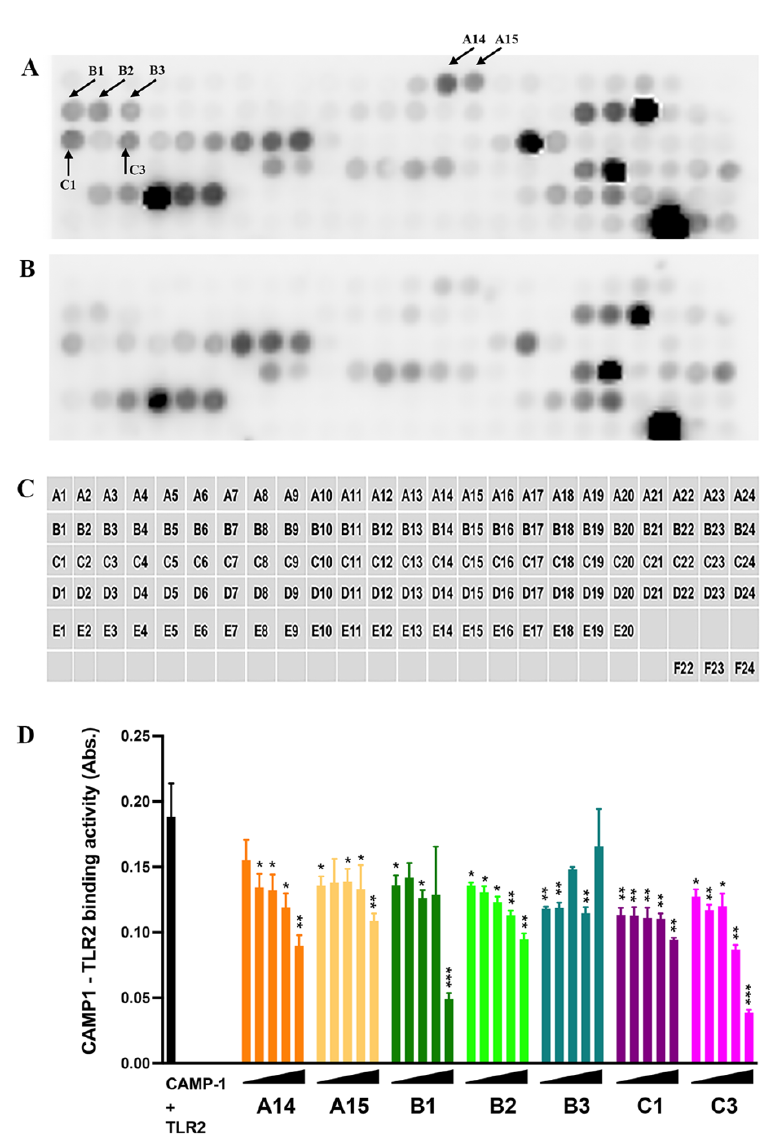
Figure 4. Subpeptides from CAMP1 recognized by TLR-2. ( A , B , C ) The peptides derived from CAMP1 proteins: group F (positions A1-C21), group A (positions C22-E9), group C (positions E10-E13), group D (positions E14-E17), group E (positions E18-E20); a biotinylated peptide used as a positive control (position F22) and a peptide used as a negative control (position F24), were immobilized on glass plates. ( A ) The plates were incubated with TLR-2 (10 µ g/mL)/anti-TLR-2 antibody (0.1 µ g/mL)/HRP (0.5 µ g/mL) and ( B ) with anti-TLR-2 antibody (0.1 µ g/mL)/HRP (0.5 µ g/mL). The arrows indicate the positions of peptides specifically recognized by TLR-2. ( D ) Immobilized rCAMP1 (20 µ g/mL) proteins were probed with biotinylated TRL-2 (0.5 µ g/mL) (dark bar) after pre-treatment with peptide (A14, A15, B1, B2, C1 and C3) at various concentrations (1.25, 12.5, 125, 1250 and 12,500 nM). Statistical significance is indicated by * ( p < 0.05), ** ( p < 0.01) and *** ( p < 0.001).